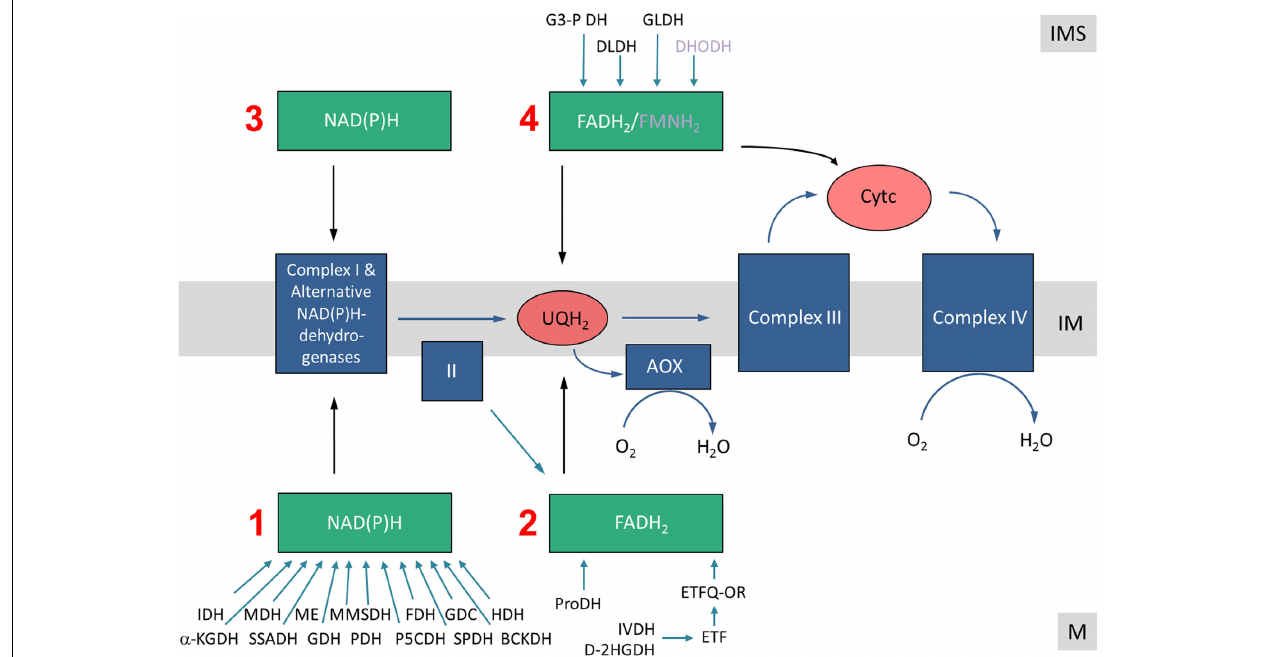
FIGURE 2 | Electron entry pathways into the mitochondrial electron transport chain in plants. Electrons enter the respiratory chain via four different pathways. (1) The Matrix-NAD(P)H pathway. Various dehydrogenases oxidize carbon compounds in the mitochondrial matrix. Electrons are transferred in the form of NADH to the ETC. NADH is re-oxidized by complex I or the internal alternative NAD(P)H dehydrogenases. (2) The Matrix-FADH 2 pathway. FAD-containing enzymes oxidize carbon compounds in the mitochondrial matrix and directly (ProDH?) or indirectly (via the ETF/ETFQQ system) transfer electrons to the ubiquinone pool. (3) The IMS-NAD(P)H pathway. Cytoplasmically formed NAD(P)H is re-oxidized via external alternative dehydrogenases. (4) The IMS-FADH 2 pathway. FAD/FMN-containing enzymes oxidize carbon compounds in the mitochondrial intermembrane space. Electrons are transferred either to the ubiquinone or the cytochrome c. M, matrix; IM, inner membrane; IMS, intermembrane space. Abbreviations— alphabetically ordered .